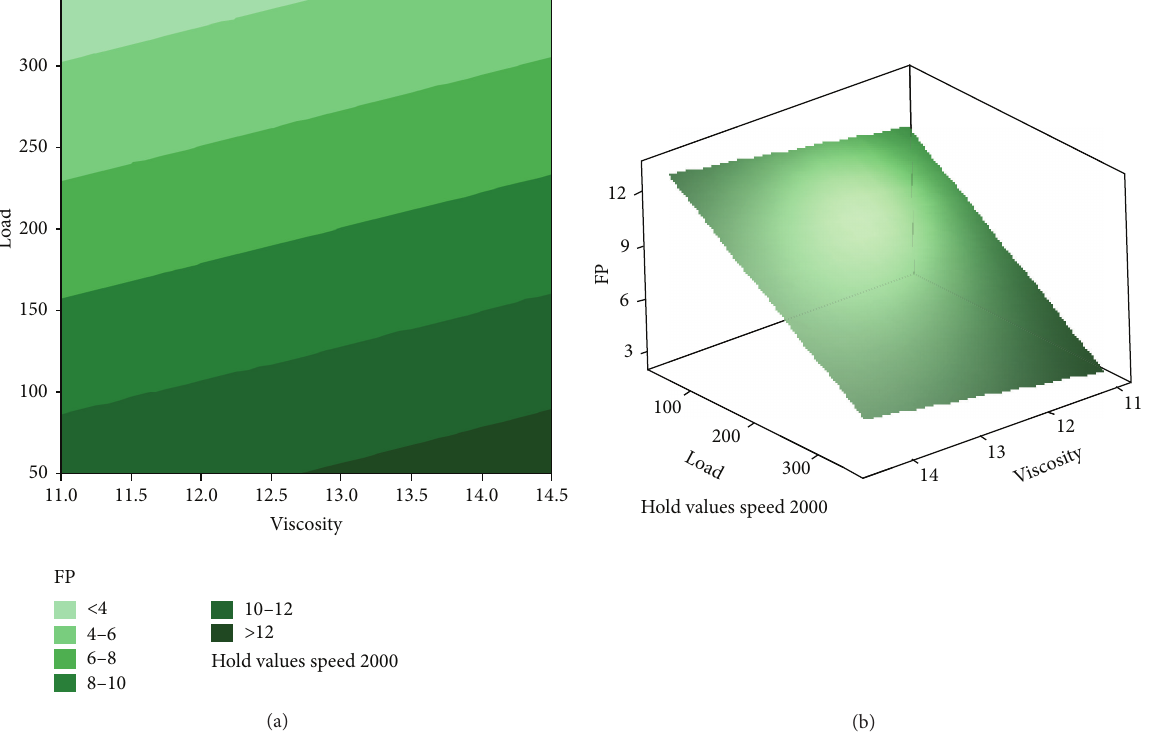
Figure 7: (a) Contour plot of FP versus viscosity and load at a speed of 2000 rpm. (b) Response surface plot of FP versus viscosity and load at a speed of 2000